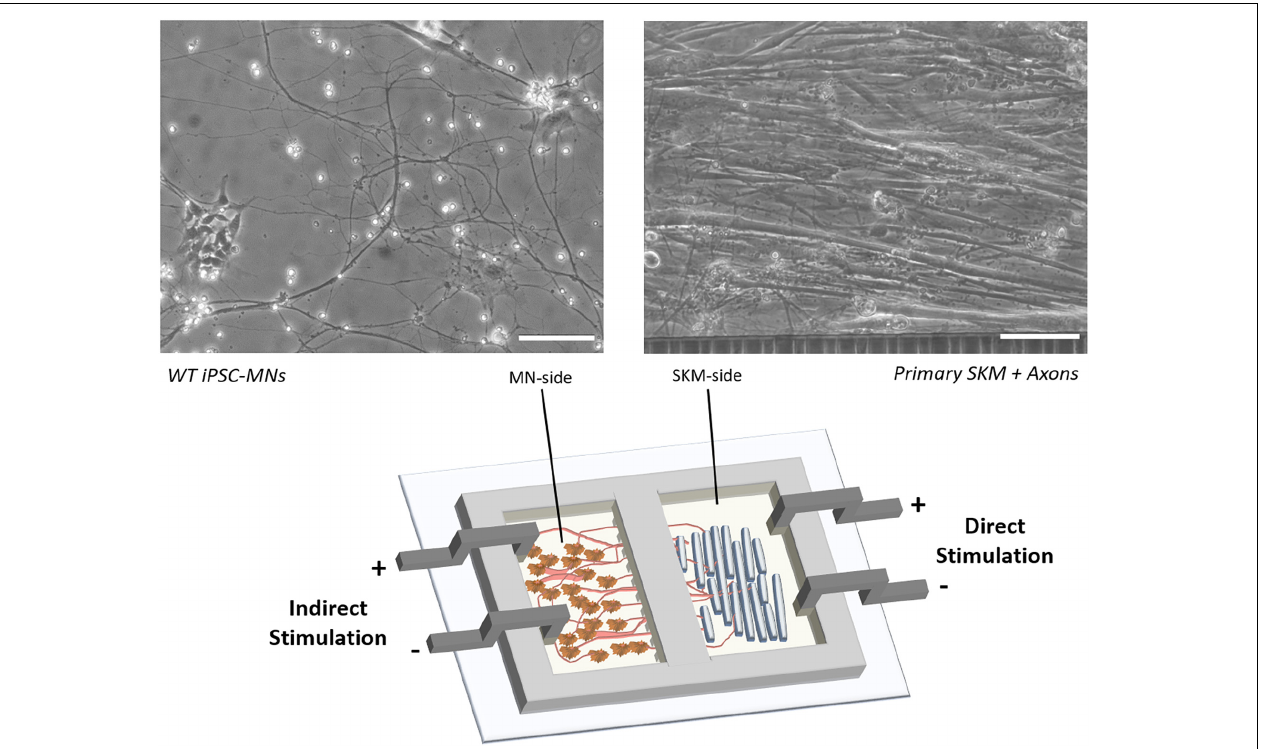
FIGURE 2 | Schematic of NMJ chamber with primary SKM innervated by WT iPSC-MNs and electrically stimulated by electrodes for either direct (SKM-side) or indirect (MN-side) stimulation. Phase images indicate the morphology of co-culture on SKM innervated by axons progressing through tunnels (right) and WT iPSC derived MNs (left). Scale bars = 100